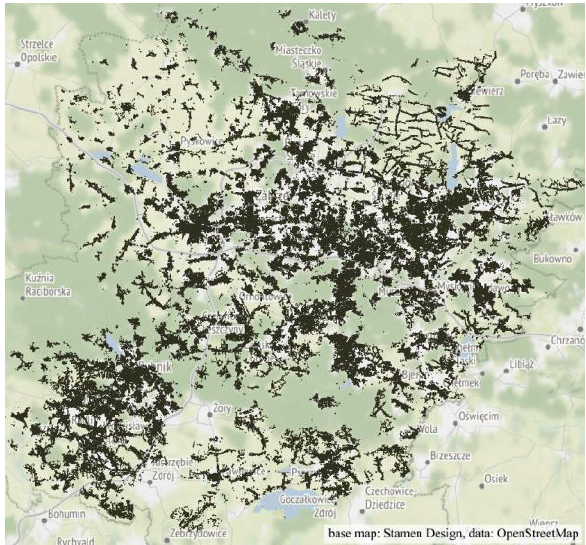
Figure 5. City model: 554,763 buildings in CityGML